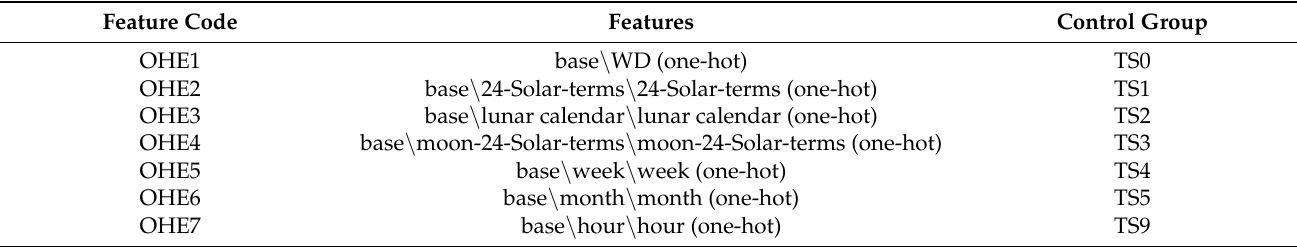
Table 6. One-hot encoding feature treatments.